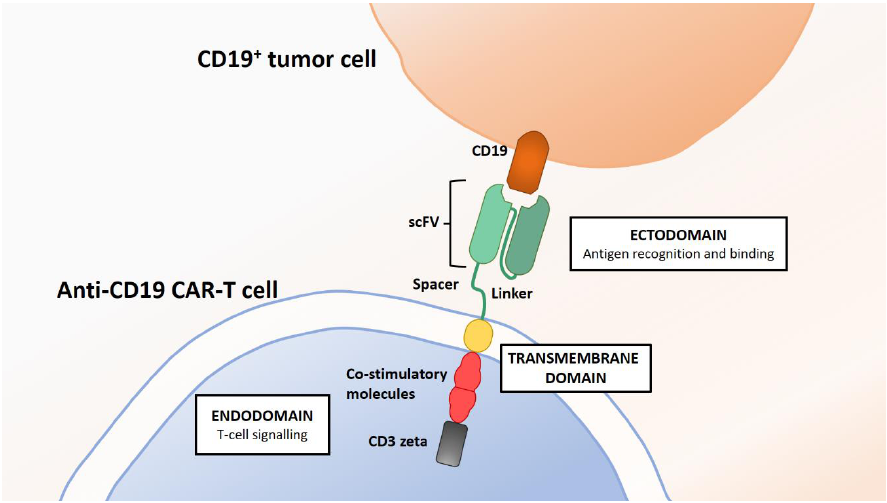
Figure 3. Interaction between anti-CD19 CAR-T cell receptor and CD19 antigen-presenting tumor cell. Chimeric antigen receptors on the anti-CD19 CAR-T cells consist of extracellular, transmembrane, and endodomain / intracytoplasmic regions, which are inserted into T cells to form an antigen